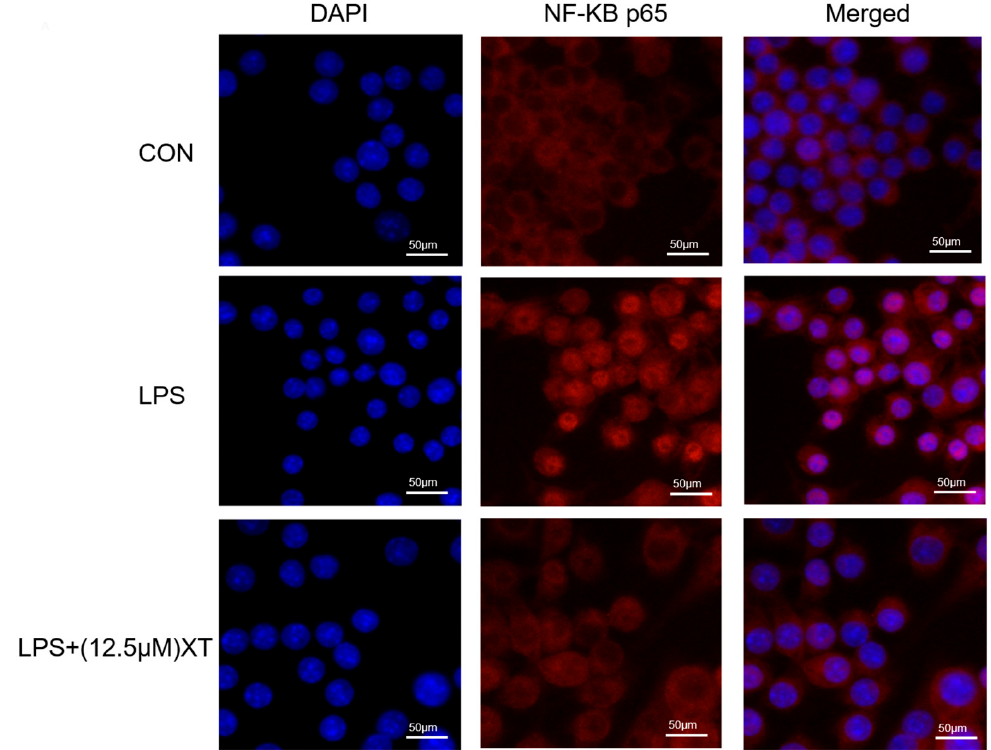
Figure 8. Effects of xanthatin on the NF −κ B p65 nuclear translocation in LPS − induced RAW 264.7 cells. Scale bar = 50 μ m. When cells were pre − treated with xanthatin and activated by LPS, we used it to evaluate the NF −κ B p65 nuclear translocation by laser confocal scanning electron microscopy. NF −κ B p65 antibodies (red) and DAPI (blue) were used to stain the cells.